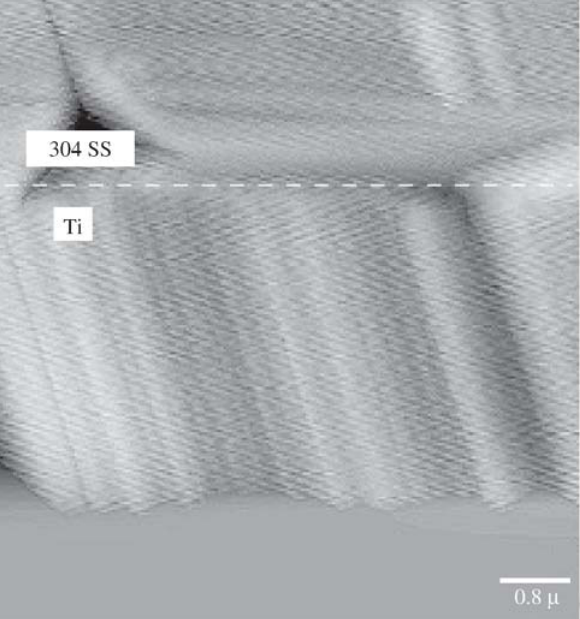
Figure 2. An AFM image of the cross-section observation of the microstructure of titanium film deposited on 304 SS substrate by electron beam evaporation indicating a columnar growth.